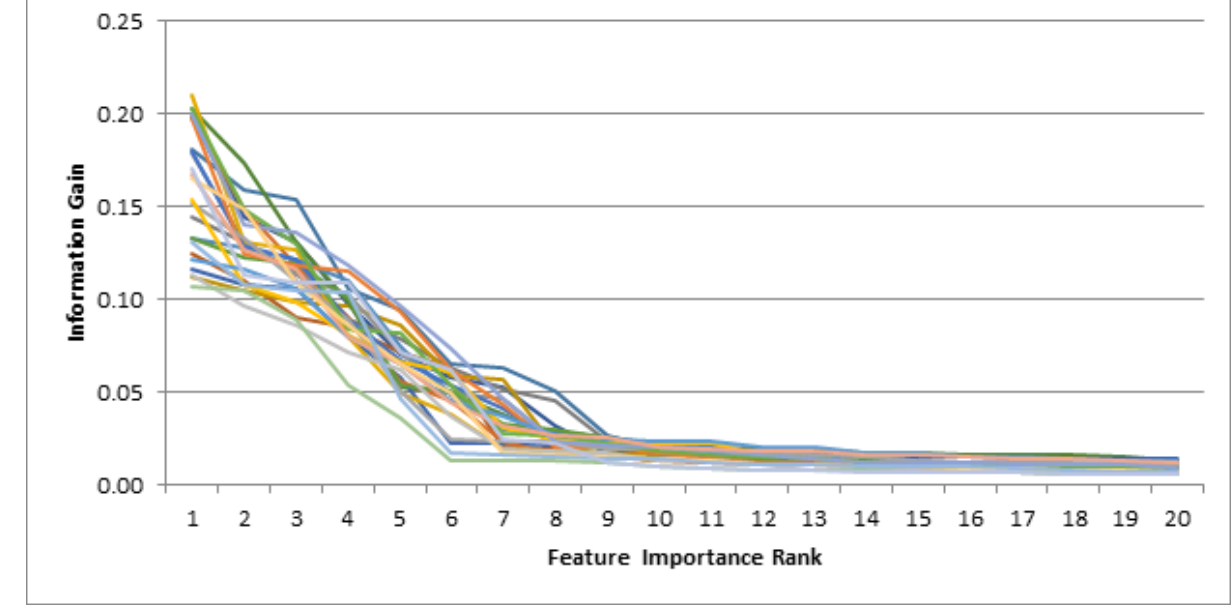
Figure 4. Ranking of features based on the importance calculated using information gain for all 25 different training